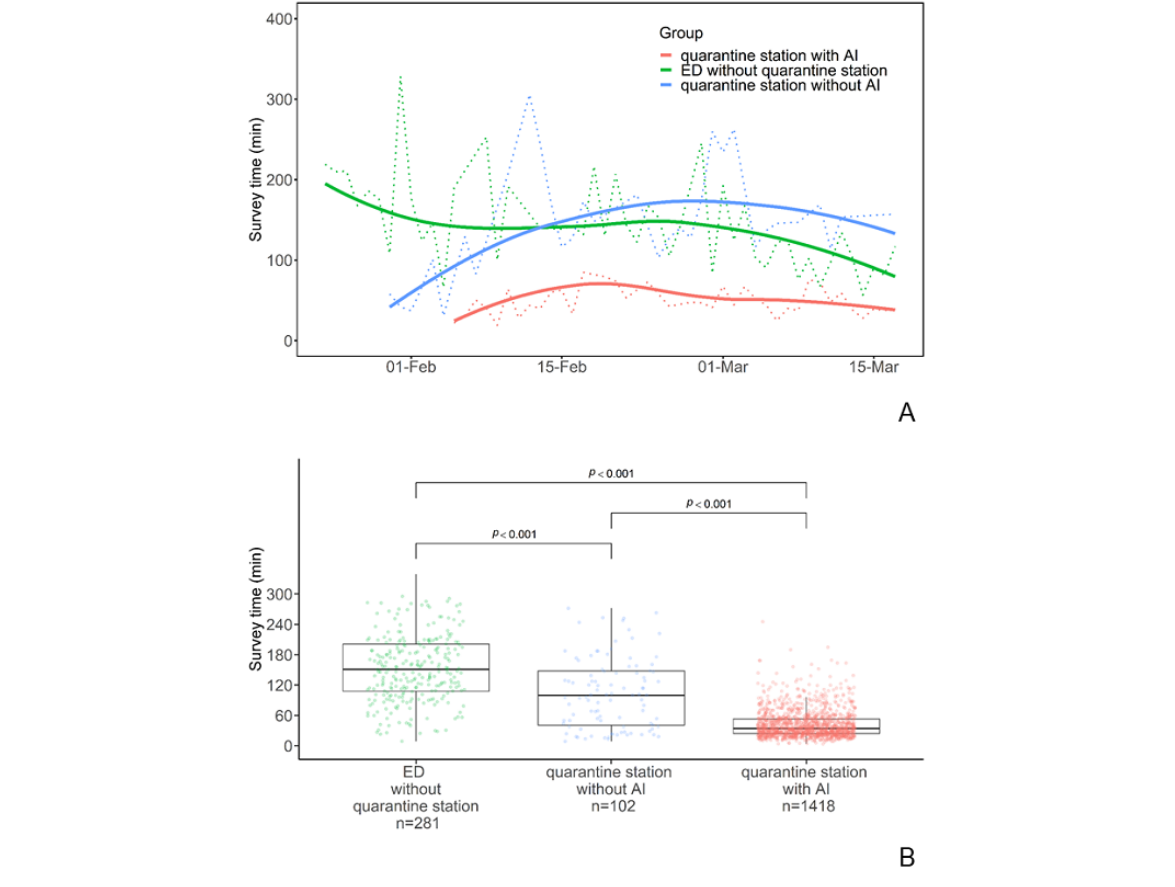
Figure 8. (A) Comparison of survey processing times over the study period between the traditional ED and quarantine station groups with or without AI applications. (B) Box plots of the survey processing times for the traditional ED group, the quarantine station group without AI, and the quarantine station group with AI. AI: artificial intelligence; ED: emergency department; min: